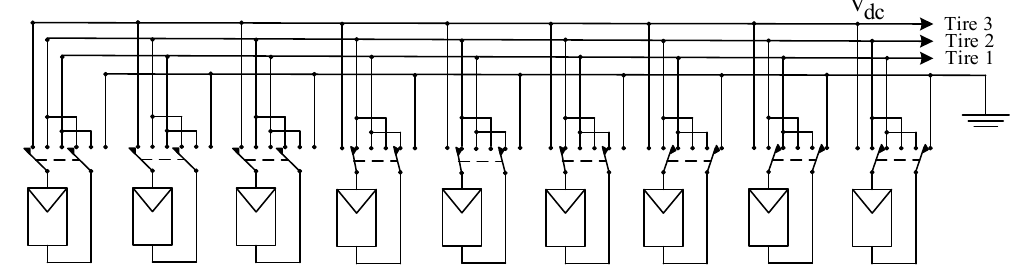
Figure 7. Switching Matrix for a reconfigurable 3x3 TCT array (normal configuration) [22].